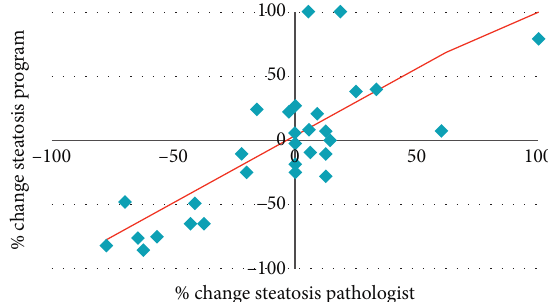
Figure 11: Scatter diagram. % change steatosis program − % change steatosis pathologist.